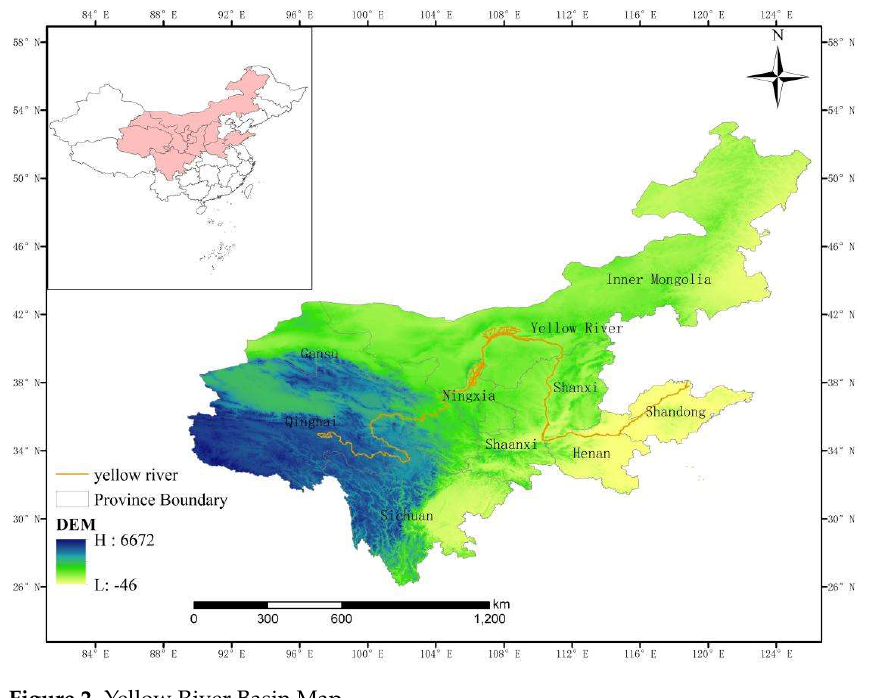
Figure 2. Yellow River Basin Map.